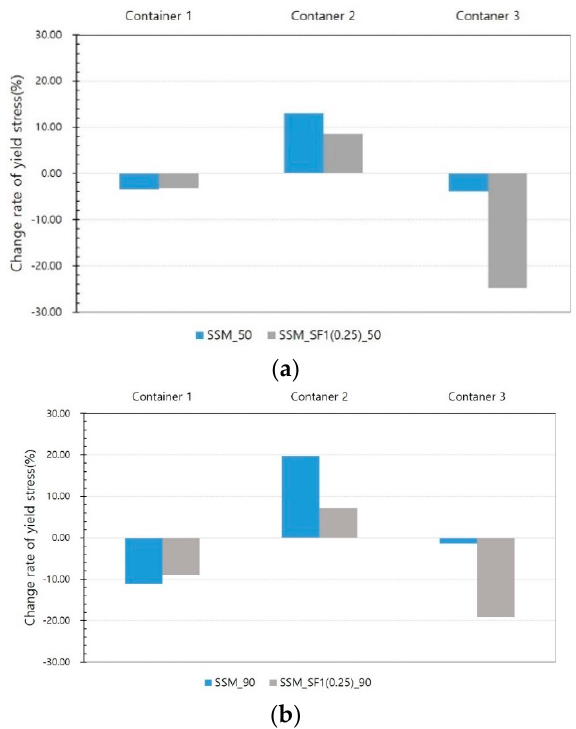
Figure 13. Yield stress results from Phase II test ( a ) at 50 V, ( b ) at 90 V. This trend is the same at 50 and 90 V. The yield stress decreases in container 1 but increases in container 2. In container 3, a large reduction in the yield stress is observed.